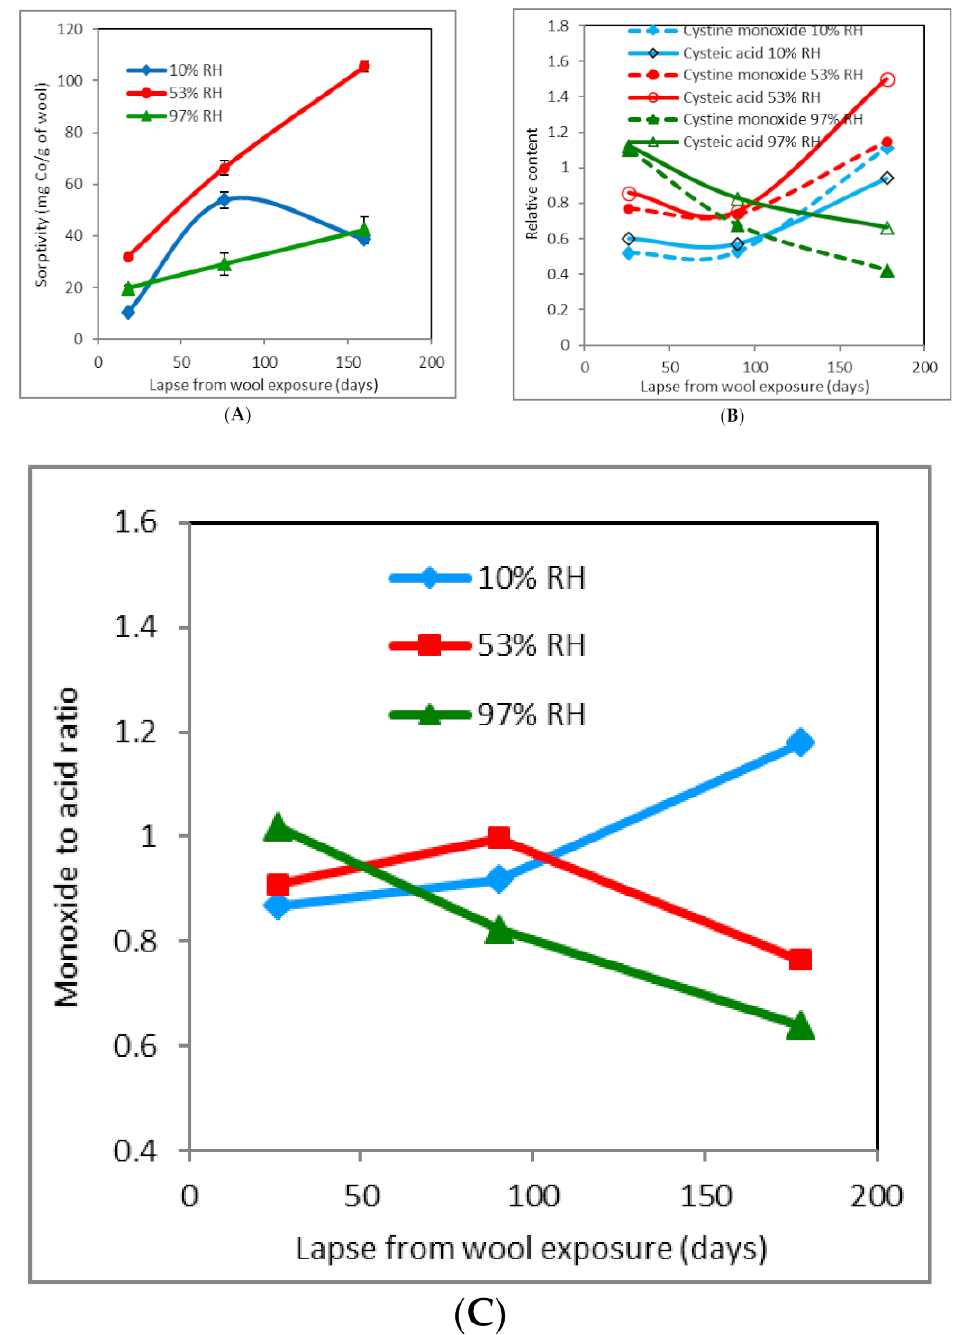
Figure 4. Time development of sorptivity ( A ), relative content of cysteic acid and cystine monoxide ( B ), and cystine monoxide to cysteic acid ratio ( C ) for wool pre-conditioned at different RH and dosed 257 kGy. Measurements were performed after subsequent storage under laboratory